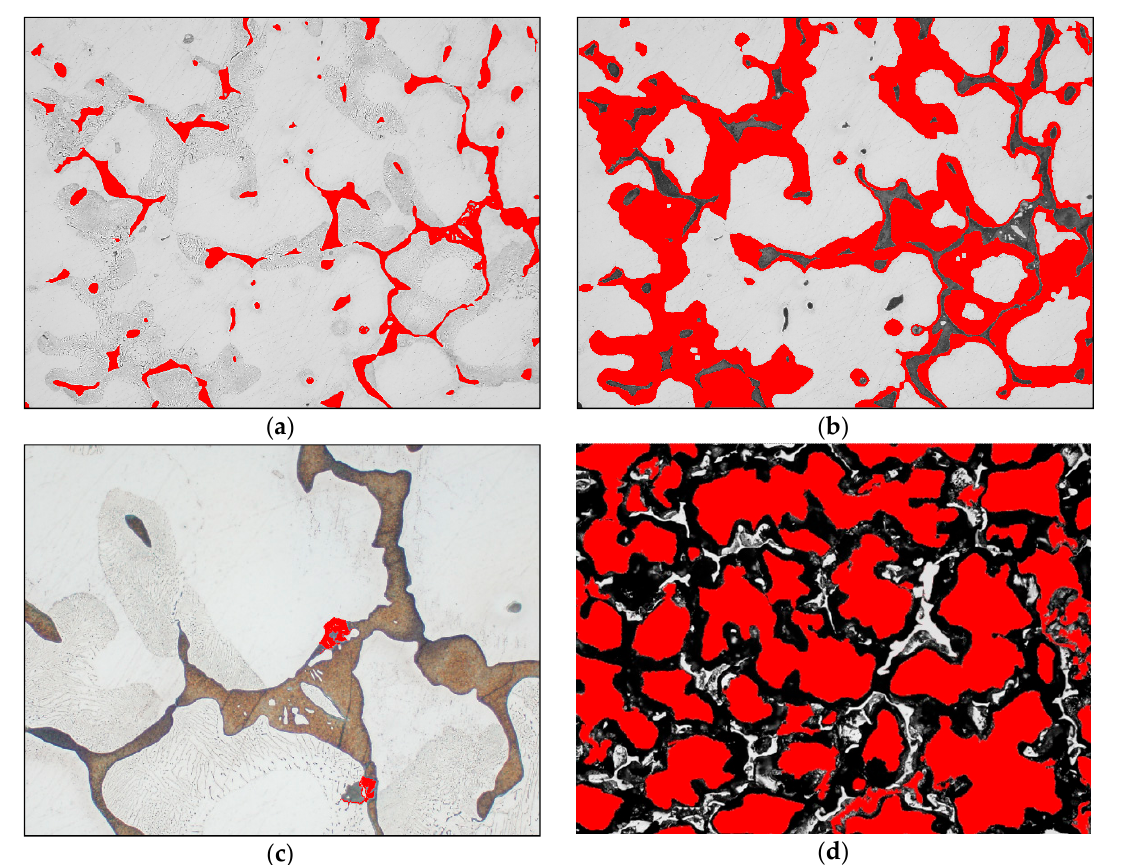
Figure 1. Conditions of phase detection: ( a ) continuous Mg 17 Al 12 , ( b ) discontinuous Mg 17 Al 12 , ( c ) Mg 2 Si phase, ( d ) α -Mg solid solution.